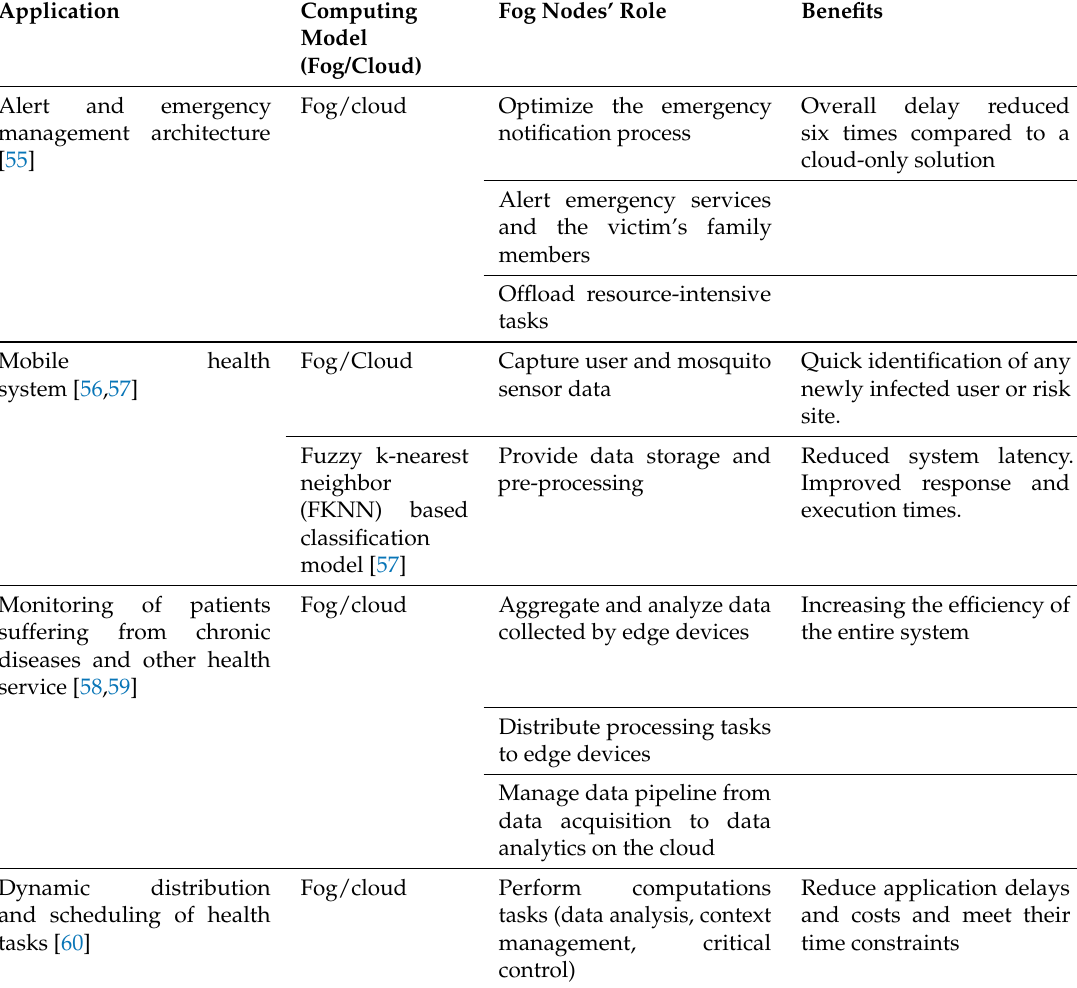
Table 2. Fog computing-based healthcare